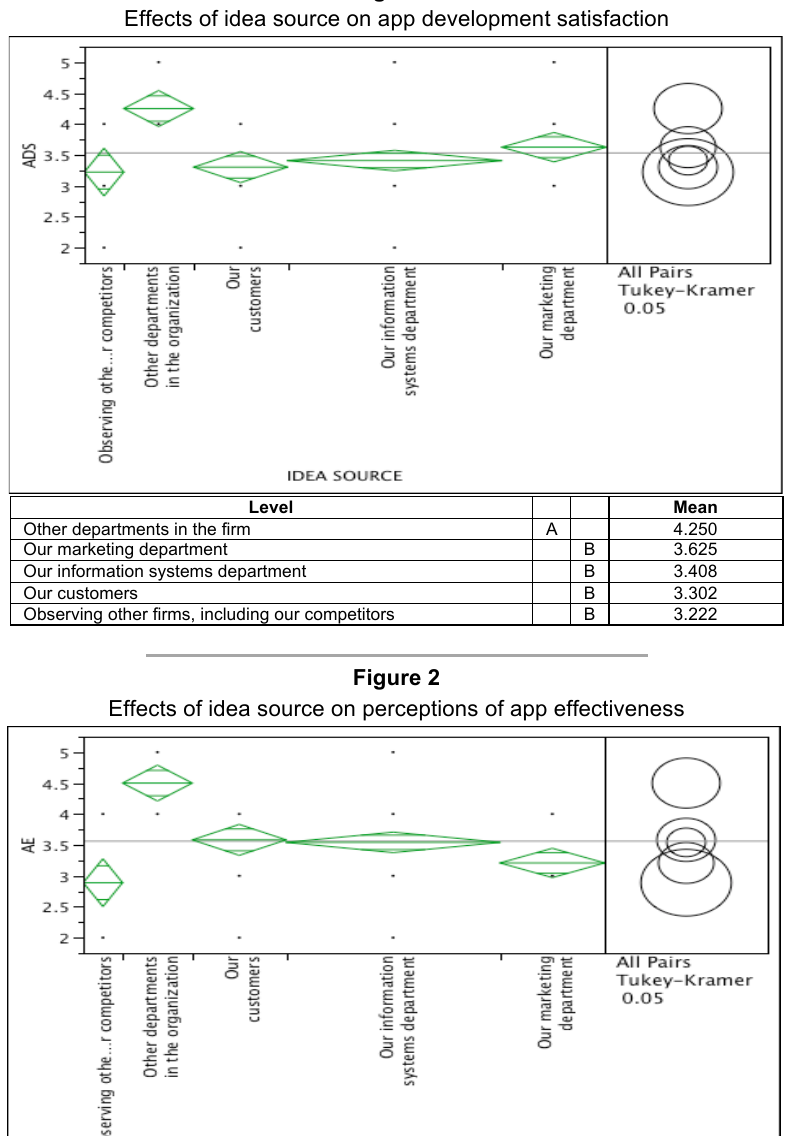
Effects of idea source on app development satisfaction